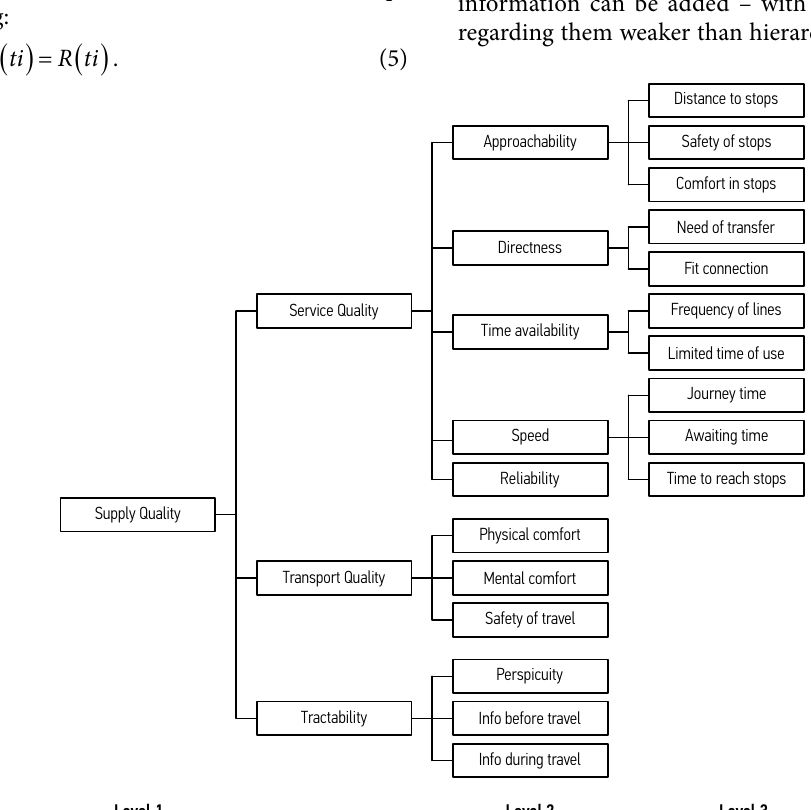
Fig. 1. The hierarchical model of public bus transportation supply